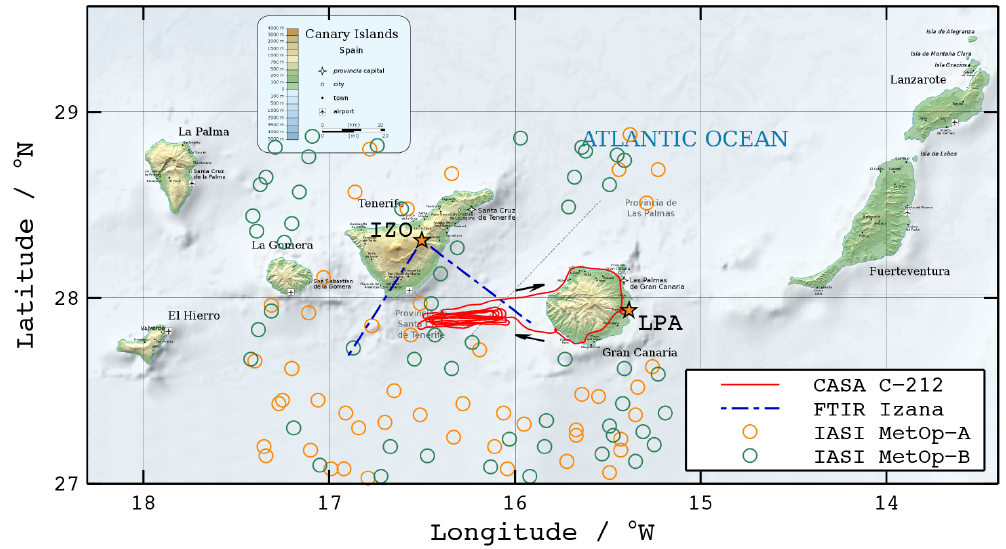
Figure 6. Aircraft flight track (red) of 24 July 2013 departing from Las Palmas Airport (LPA). Also shown are all MetOp-A and MetOp- B measurements (symbols) obtained during the campaign after a data-quality filter was applied. The FTIR line of sight (blue lines) for 10:30 and 13:00UTC (start and end of profile measurements) at Izaña (IZO) is indicated. Map source: http://en.wikipedia.org/wiki/File: